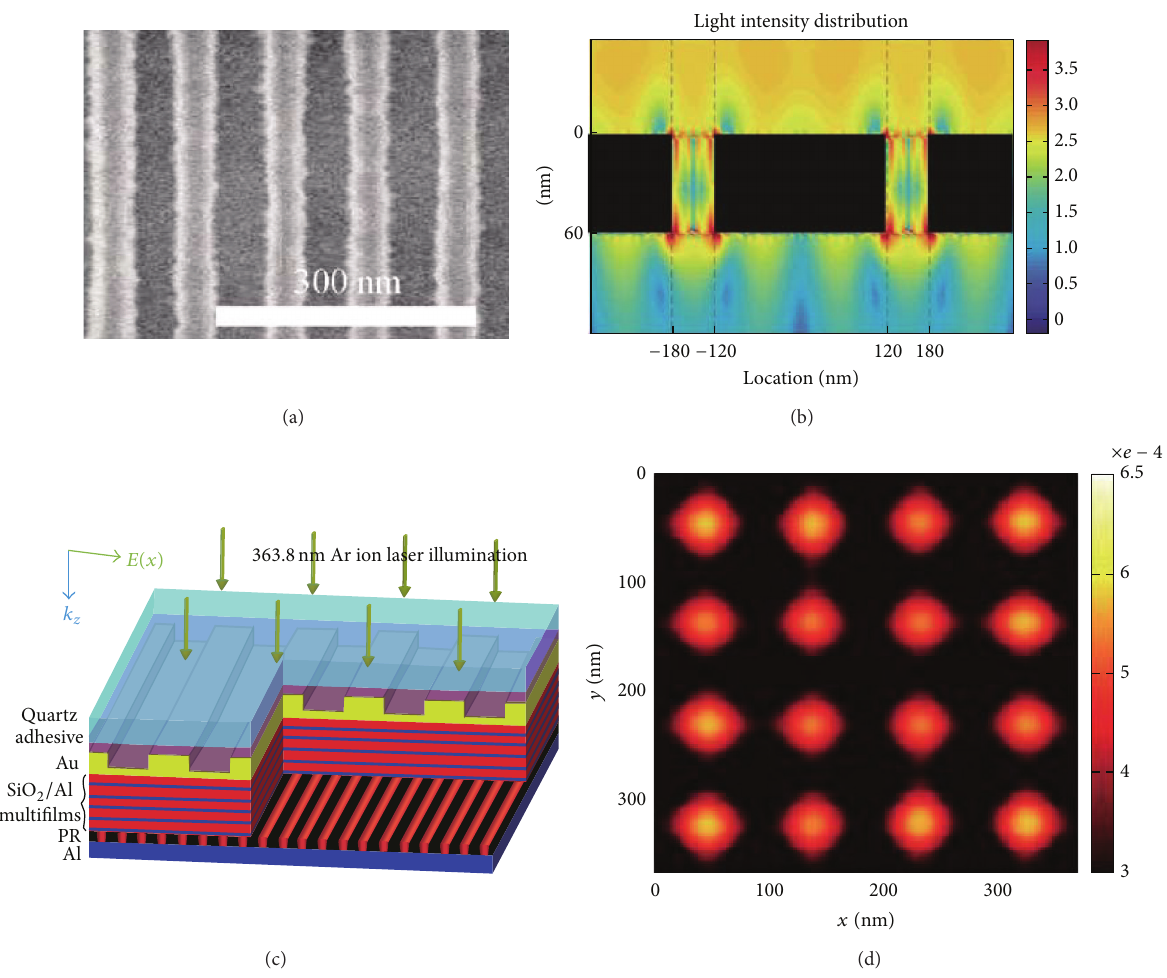
Figure 53: Interference lithography by surface plasmon polariton. (a) SEM image of the fabricated sample. (b) Simulated electric field distribution. (c) Schematic of the improved lithography technique. (d) Two-dimensional interference patterns. Figures are reproduced from [31,